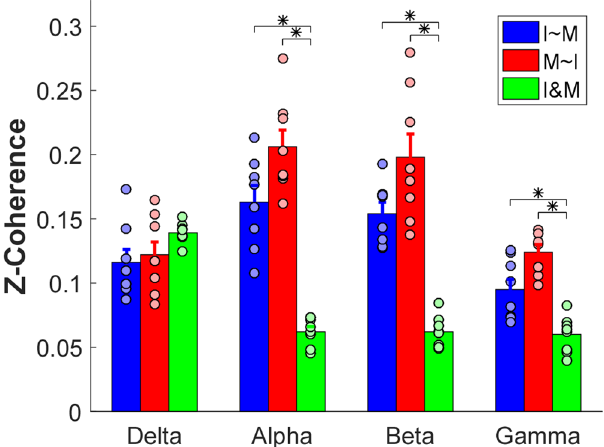
Figure 4. Overall comparisons across two partial residuals and cross-compartment coherence in the index vs. middle combination. Each bar represents the average magnitude of z-coherence, and the error bars represent standard error across subjects. Asterisks indicate statistical significance. The black circles represent values of individual subjects. Different colors represent the different types of coherence.